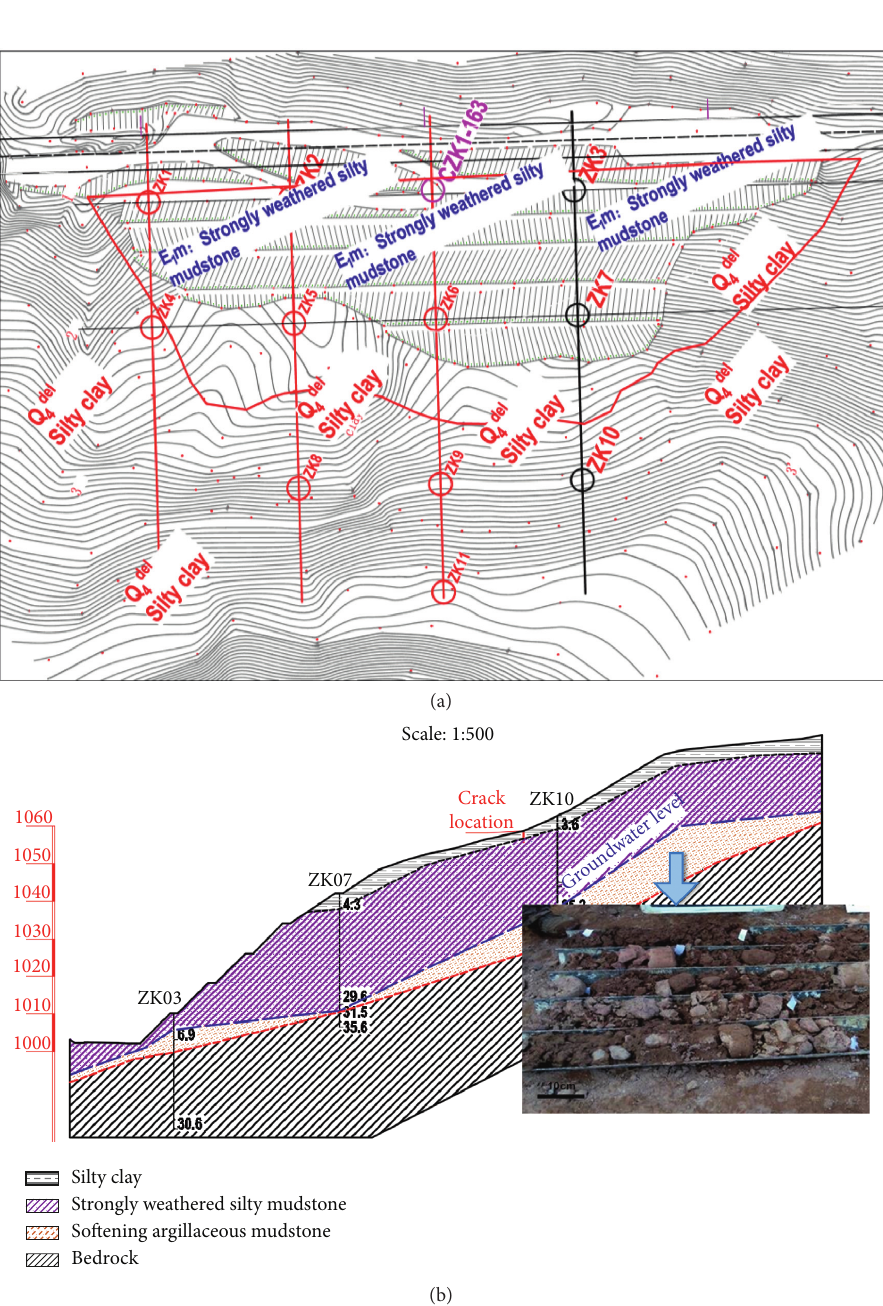
Figure 3: The (a) planar graph; and (b) cross-sectional profile of the studied